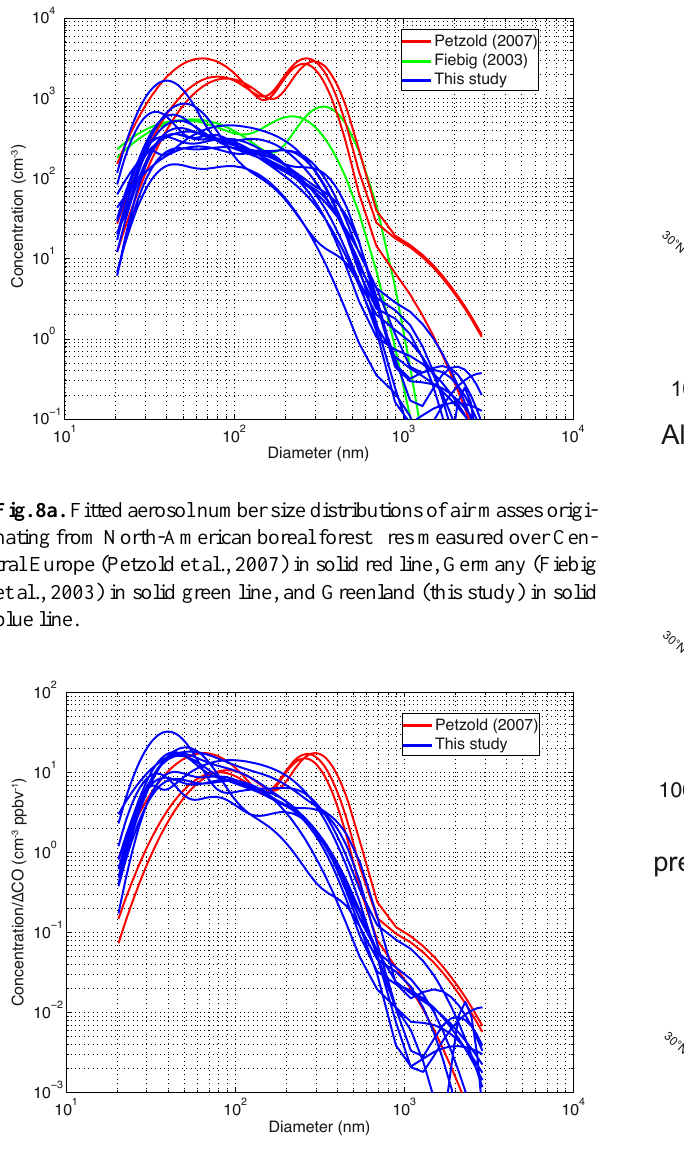
Fig. 8b. Fitted aerosol number size distributions normalised by CO enhancement for air masses originating from North-American bo- real forest fires measured over Central Europe (Petzold et al., 2007) in solid red line, and Greenland (this study) in solid blue line. Fig. 9. HYSPLIT back-trajectories for the four forest fire time win- dows on 8 July. (a) Relative humidity (RH), (b) altitude and (c) total precipitation are colour coded along the back-trajectories. Red dots symbolize fire spots from